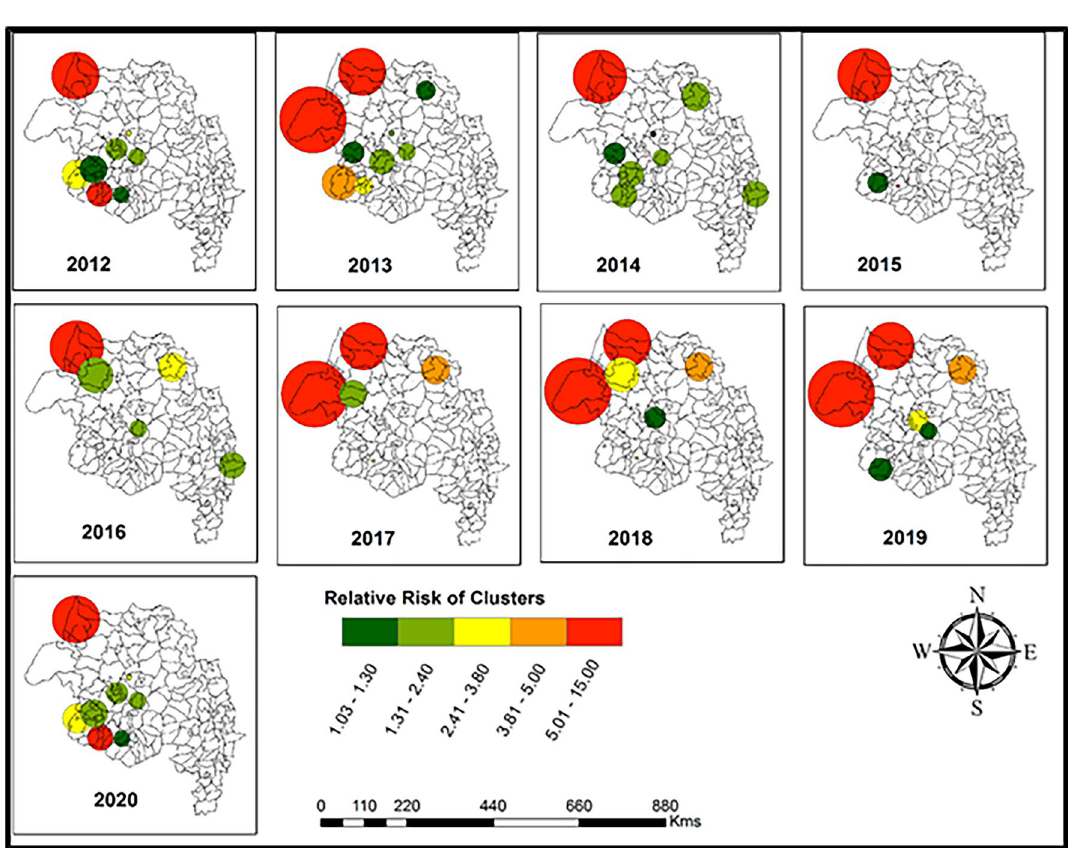
Figure 3. Detected purely spatial clusters using a discrete Poisson model in northwest Ethiopia,